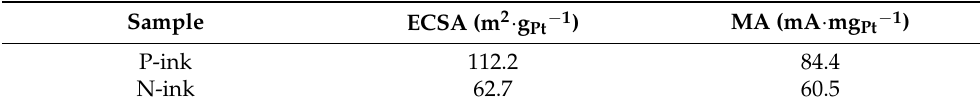
Table 5. Properties of electrodes deposited by N-ink and P-ink.